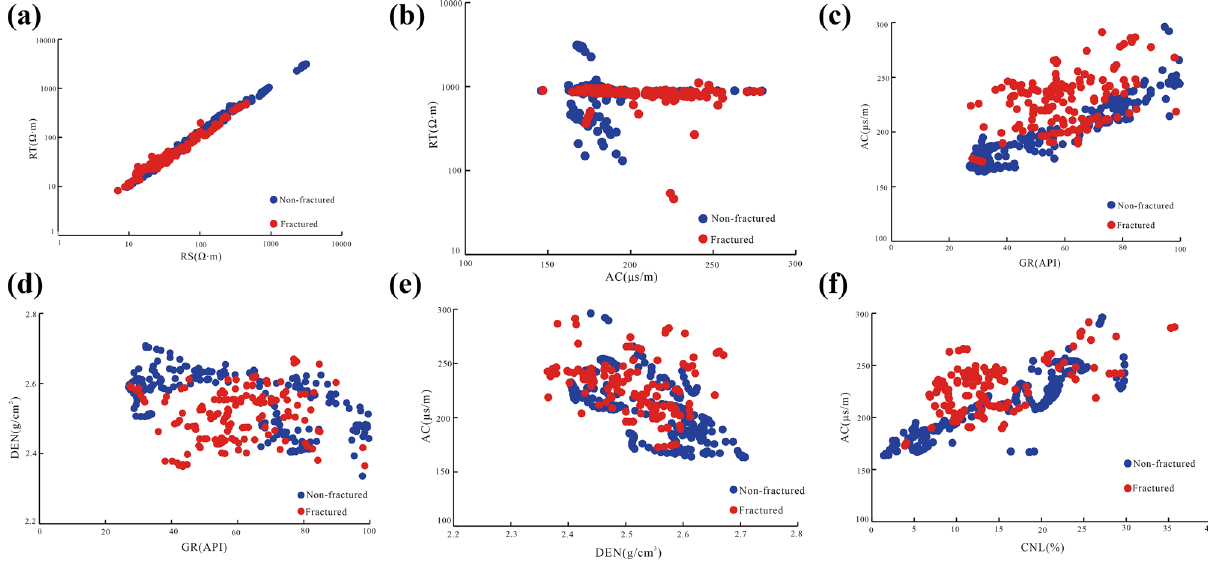
Figure 7. Logging sensitivity responses characteristics of fractured and intact